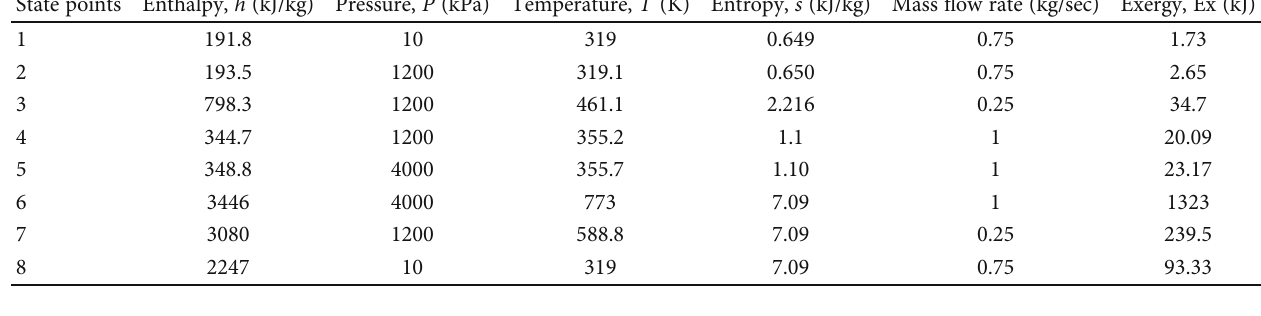
Table 3: Thermodynamic properties of regenerative Rankine cycle.